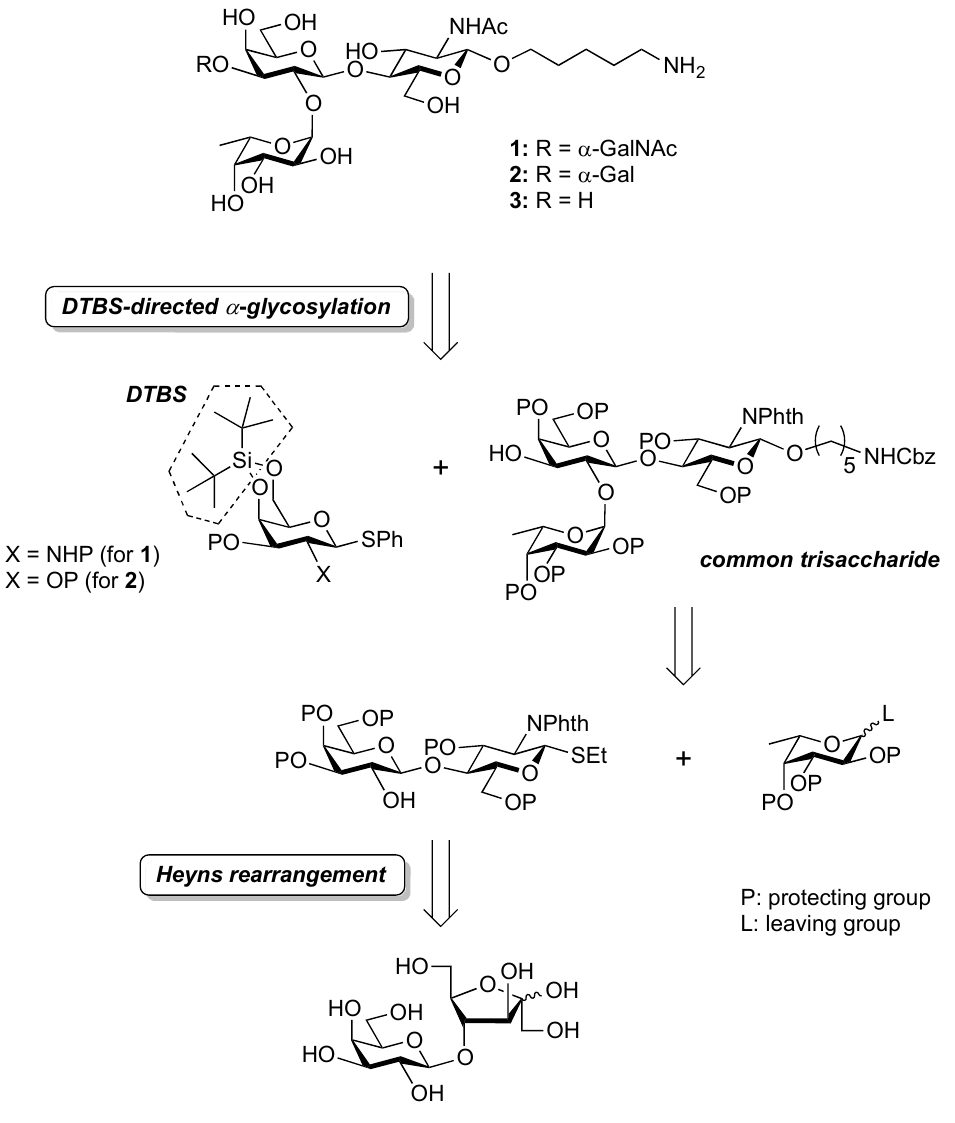
Scheme 1. Retrosynthetic analysis of target